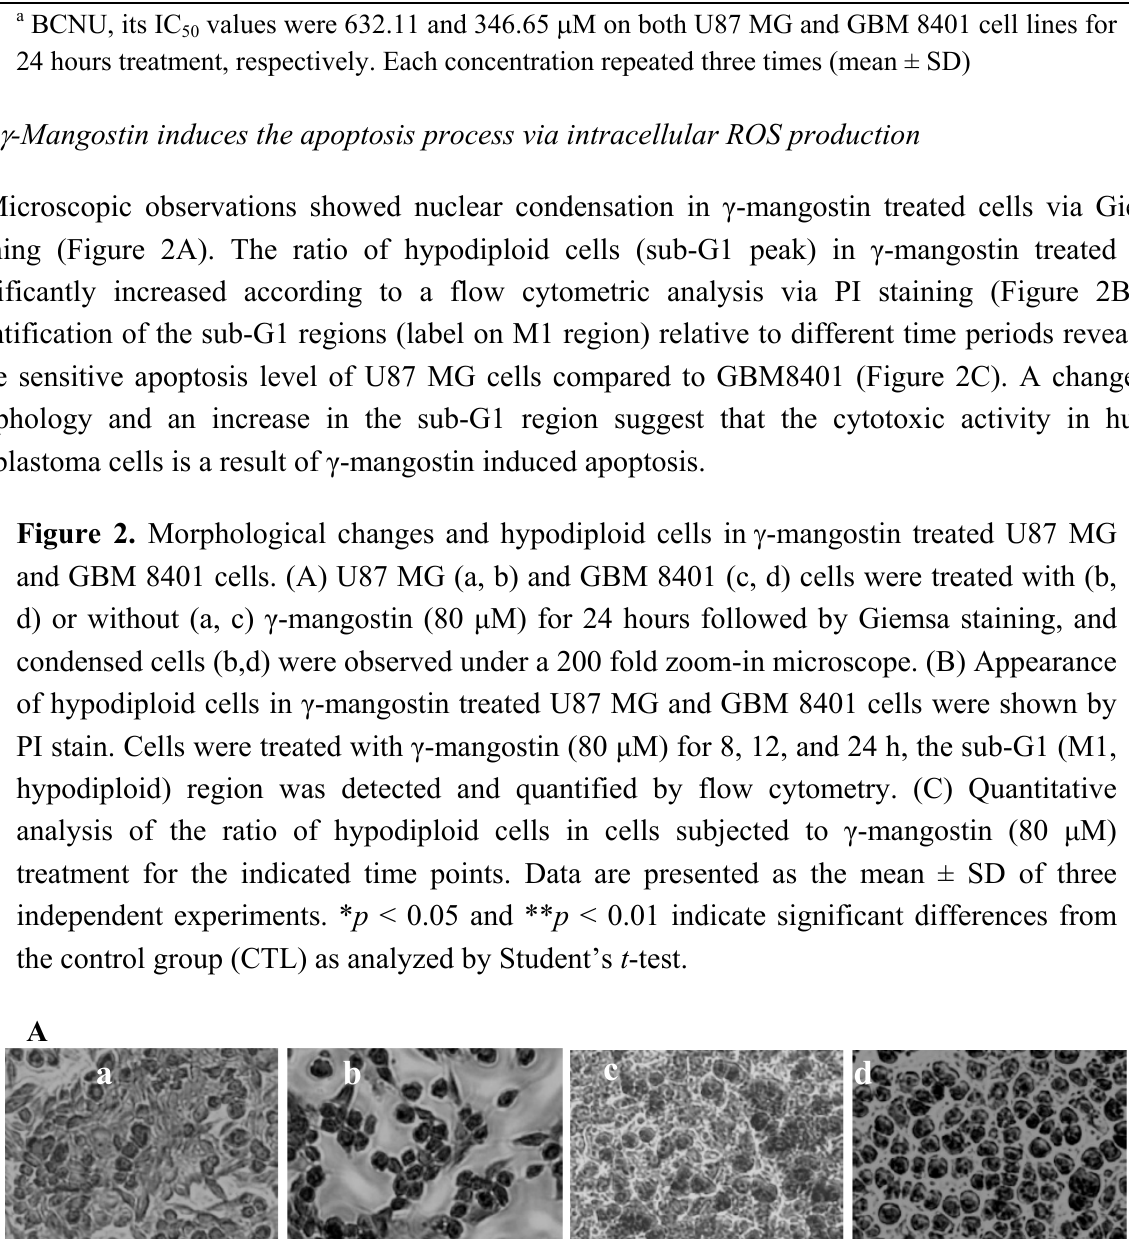
concentration 50